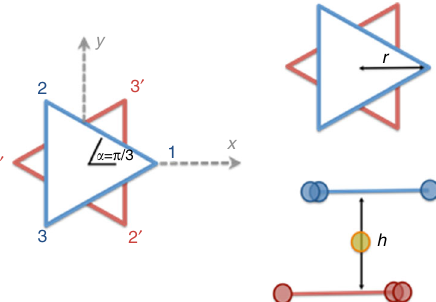
Fig. 6 Schematic diagram to describe exchange coupling. Schematic representation of the idealized geometry used to describe magnetic coupling in {Dy 6 Cr} via Hamiltonians Eqs. (1)